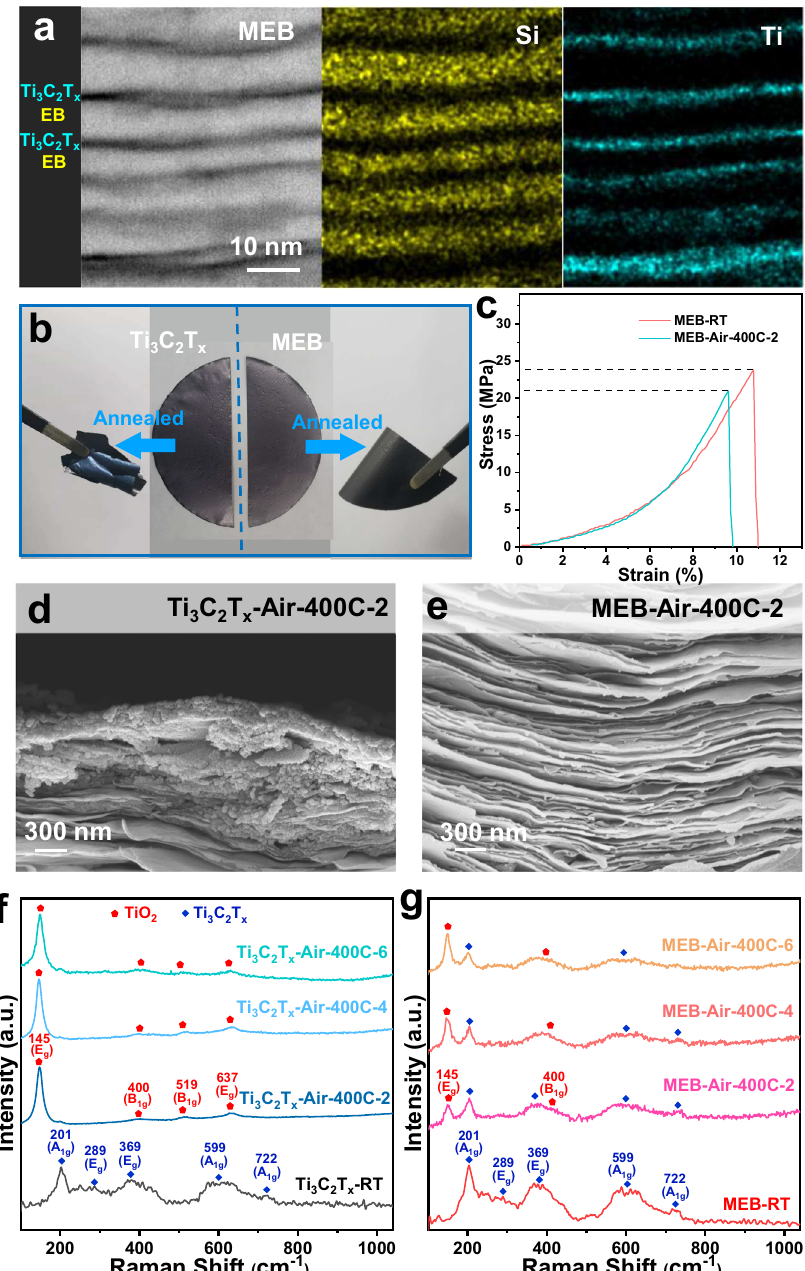
fi lms ( d ) and MEB fi lms ( e ). f Raman spectra of Ti fi lms before and after 3 C 2 T x treatment under synthetic air at 400°C for 2, 4, and 6h. g Raman spectra of MEB fi lms before and after treatment under synthetic air at 400°C for 2, 4, and 6h. Source data are provided as a Source Data fi